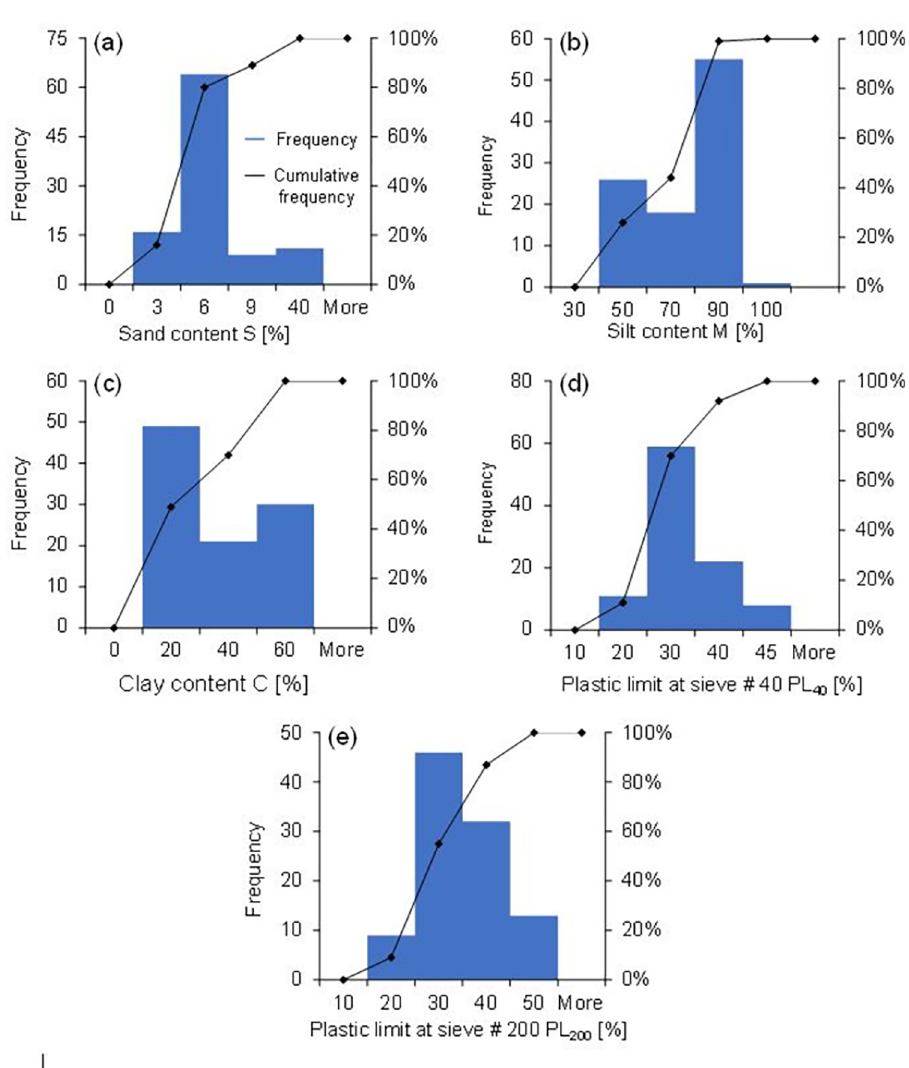
Fig 5. Frequency distribution histograms of experimental data: (a) sand content S [%]; (b) silt content M [%]; (c) clay content C [%]; (d) plastic limit from sieve # 40 passing material PL 40 [%]; (e) plastic limit from sieve # 200 passing material PL 200